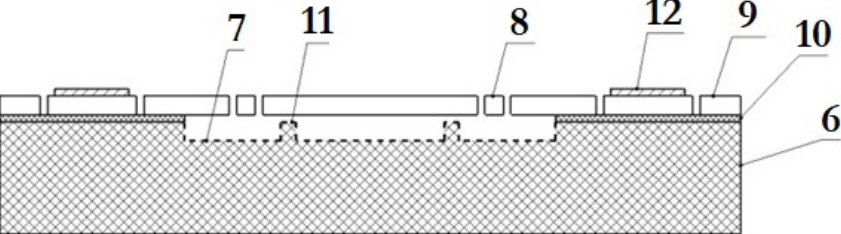
Figure 5. The developed structure: the cross-section of the SE of the MEMS gyroscope. ( 6 ) substrate of glass, ( 7 ) cavities, ( 8 ) elastic elements, ( 9 ) silicon instrument layer, ( 10 ) (SiO 2 ), ( 11 ) support, ( 12 ) metallization